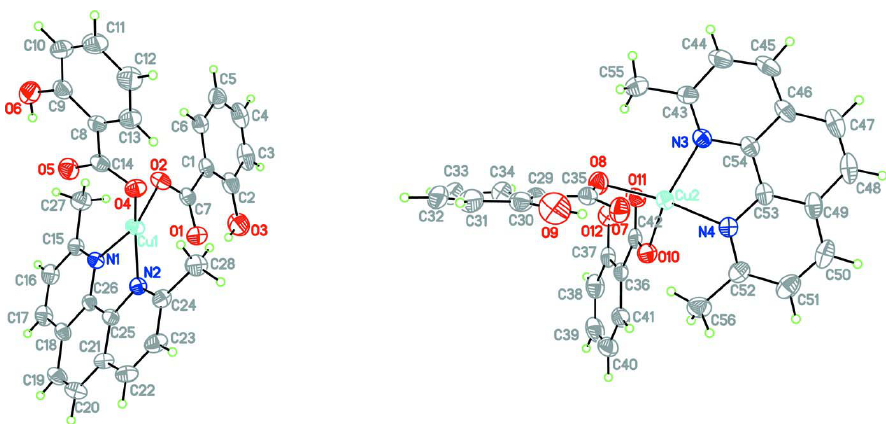
Figure 1 The molecular structure of the title complex(I), with atom labels and 30% probability displacement